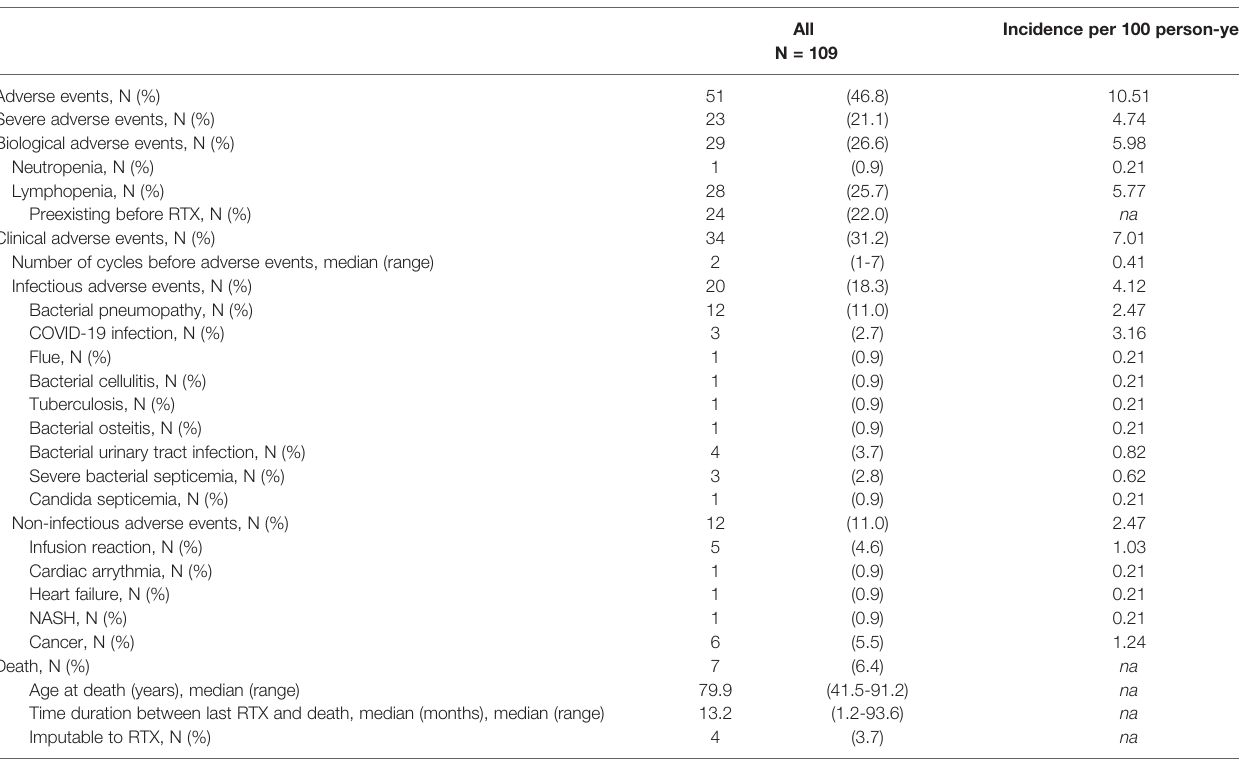
TABLE 4 | Adverse events during